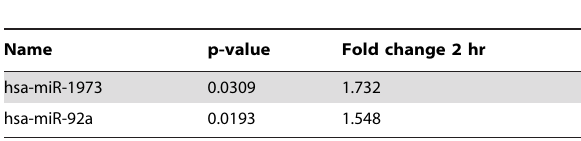
Table 2. Differentially expressed miRNA species in H9 hESC at 2 hr post 1 Gy of X-ray exposures (p ,